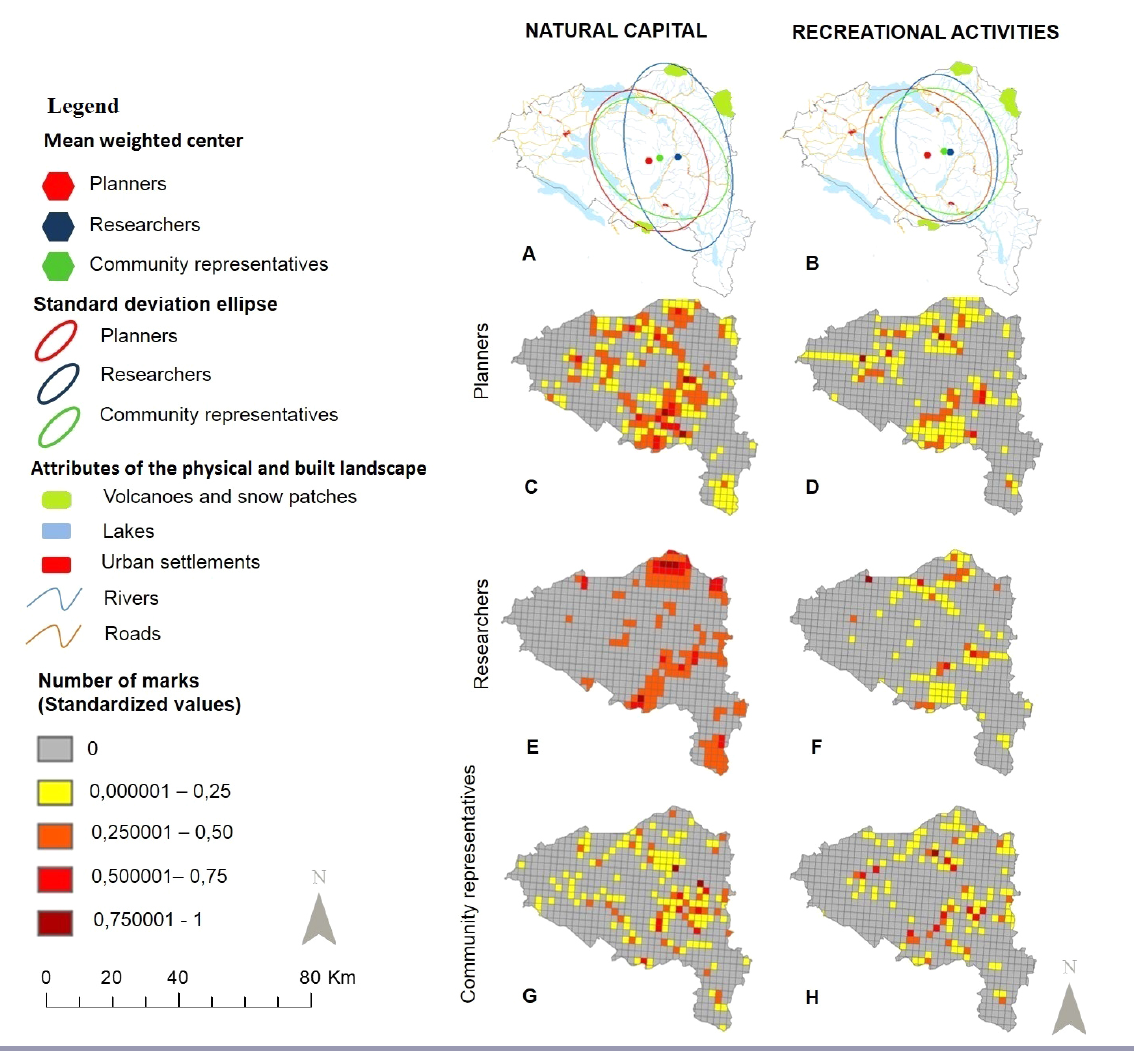
Fig. 4 . Maps of central tendencies (panels A and B) and distribution of social values for recreation opportunities, obtained from the spatial analysis of the marks assigned by the three stakeholder’s groups to natural capital (panels C, E, G) and recreational activities (panels D, F,